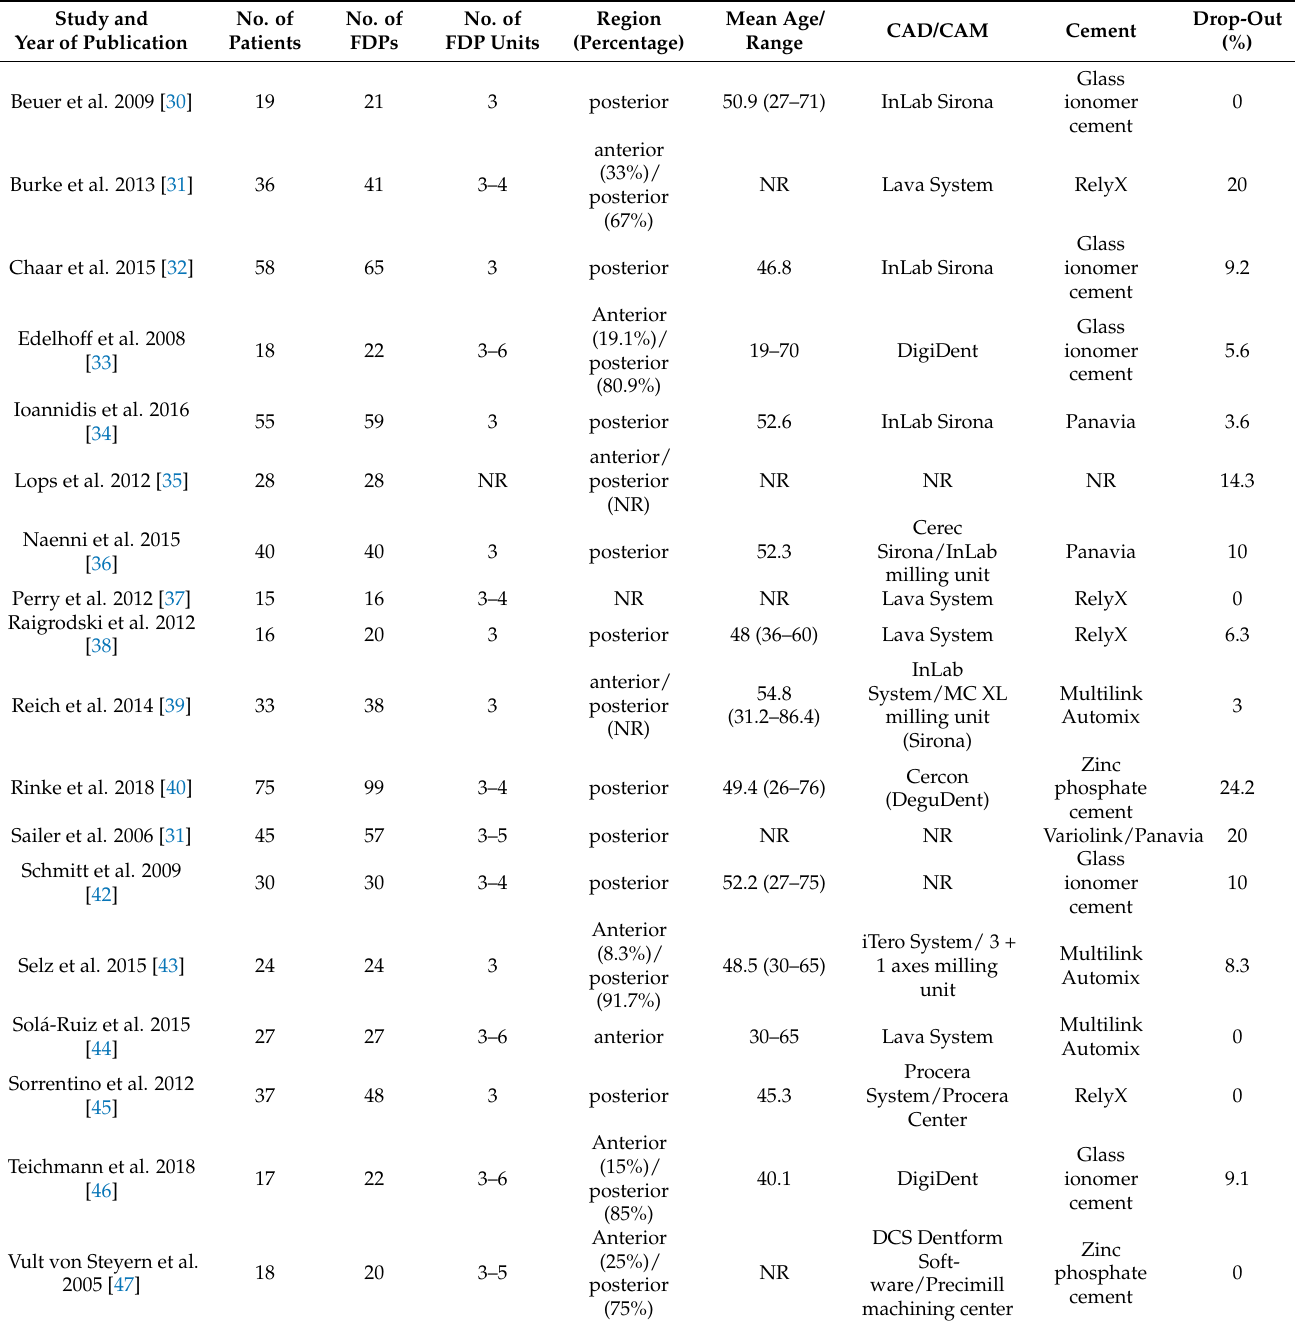
Table 1. Baseline characteristics of included